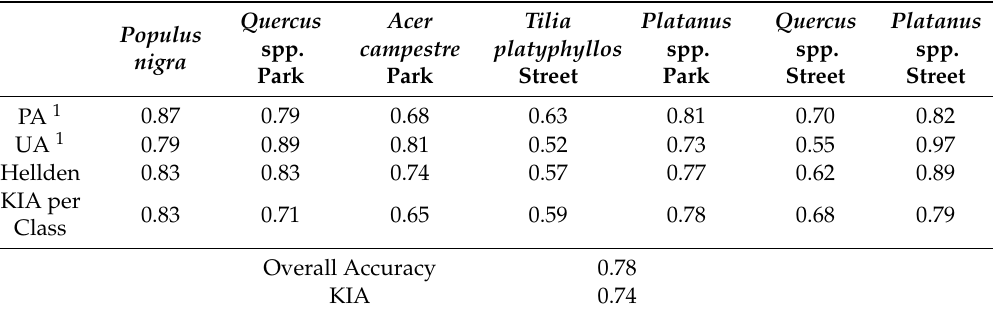
Table 3. Validation results expressed in